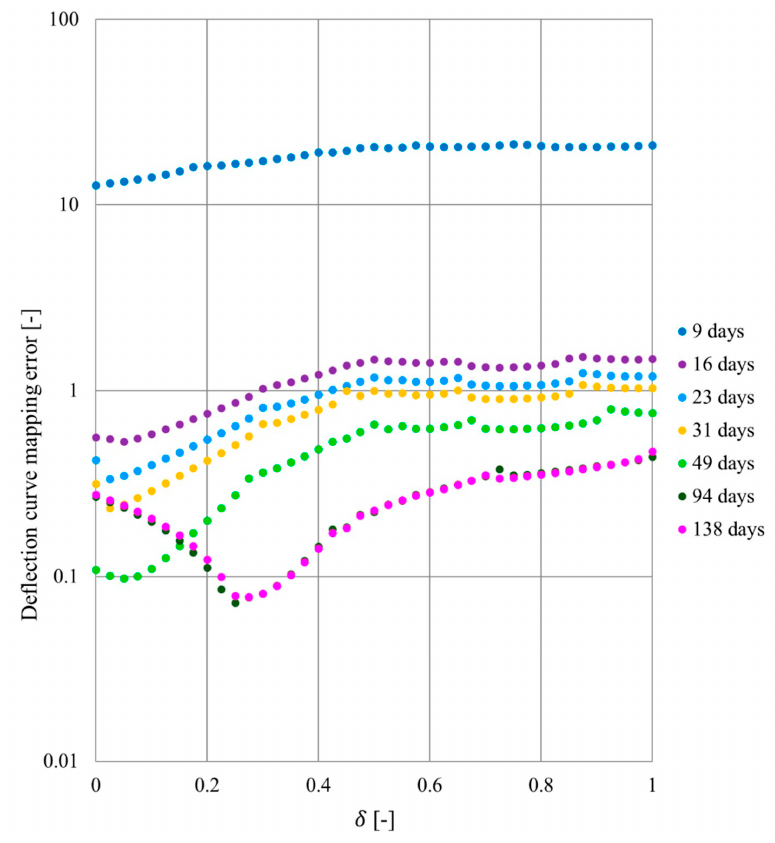
Appl. Sci. 2020 , 10 , x FOR PEER REVIEW Figure 15. Deflection curve mapping error as a function of parameter